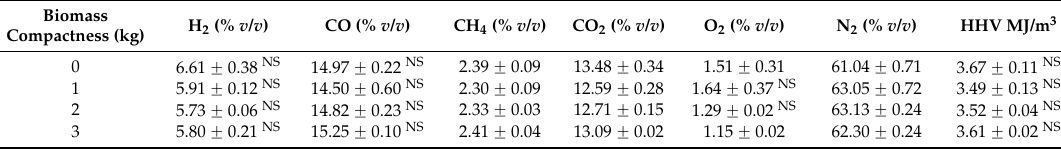
Table 4. Syngas composition and higher heating value at varying biomass compactness (airflow 20 lpm, 10% moisture content, avg. particle size 7